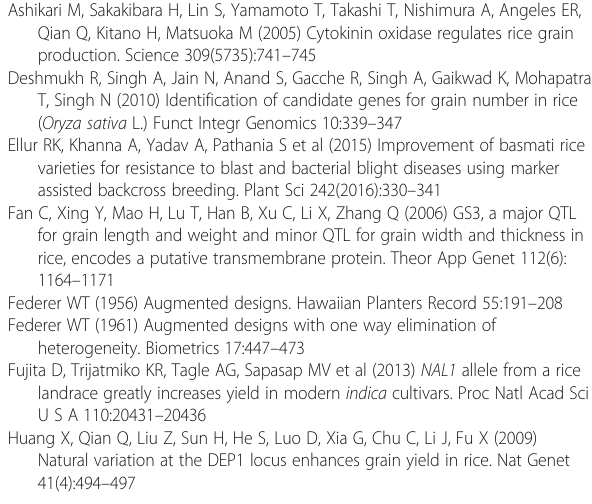
Additional file 1: Table S6. The sequence of DNA marker and its physical position using pseudomolecule release 7 of TIGR on chromosome 4 used for introgression of QTL qGN4.1 into 12 different mega rice varieties. (DOCX 11 kb) Additional file 2: Table S1. Number of plants after foreground and recombinant selection for qGN4 . 1 QTL for high grain number into 12 different mega varieties of rice at different backcross generations. (DOCX 34 kb) Additional file 3: Table S2. Adjusted means for different morphological agronomic traits of the six different qGN4.1 QTL-NILs for each variety along with respective recipient parents in BC2F3 generation. (XLSX 23 kb) Additional file 4: Figure S1. Plant architecture of qGN4.1 QTL-NILs (left side) of rice as compared to their recipient parents (right side): (D) IR 64 (E) MTU 1010 (F) HUR 105 (scale bars: 10 cm). (TIFF 4119 kb) Additional file 5: Figure S2. Plant architecture of qGN4.1 QTL-NILs (left side) of rice as compared to their recipient parents (right side): (G) Sarjoo 52 (H) Pusa 44 (I) CSR 30 (scale bars: 10 cm). (TIFF 3856 kb) Additional file 6: Figure S3. Plant architecture of qGN4.1 QTL-NILs (left side) of rice as compared to their recipient parents (right side): (J) Ranjit (K) CR 1009 (L) Pusa Basmati 1(PB 1) (scale bars: 10 cm). (TIFF 4098 kb) Additional file 7: Table S3. Percentage genome similarity of the best eight qGN4.1 QTL-NILs of Samba Mahsuri, Swarna, MTU 1010, Sarjoo 52, Pusa 44, Pusa Basmati 1 and best two lines of Pusa Basmati 1121, IR 64, HUR 105, CSR 30, Ranjit, CR 1009 with their respective recipient parent at BC3F2 generation in the genetic background of rice analysed using OsSNPnks SNP genotyping chip. (DOCX 33 kb) Additional file 8: Figure S4. Graphical representation of RPG similarity with qGN4.1 QTL-NILs of (A) Samba Mahsuri, (B) Swarna (C) IR 64 (D) MTU 1010 (E) HUR 105(F) Sarjoo 52 (Blue colors denotes recipient segment, Red denotes donor segment and Green denotes Heterozygote). (TIFF 558 kb) Additional file 9: Figure S5. Graphical representation of RPG similarity with qGN4.1 QTL-NILs of (G) Pusa 44 (H) CSR 30(I) Ranjit (J) CR 1009 (K) Pusa Basmati 1(PB 1) (Blue colors denotes recipient segment, Red denotes donor segment and Green denotes Heterozygotes). (TIFF 476 kb) Additional file 10: Table S5. Analysis of all the affymetrix 50 K SNP calls of 12 RPG along with qGN4.1 QTL-NILs on separate sheets. (XLSX 99942 kb)